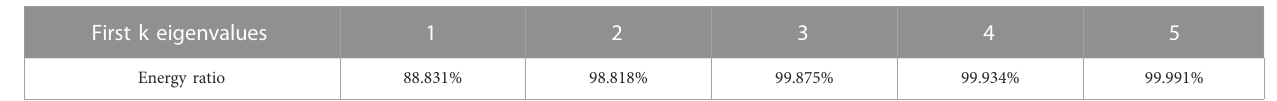
TABLE 1 Energy ratio of fi rst k eigenvalues of case